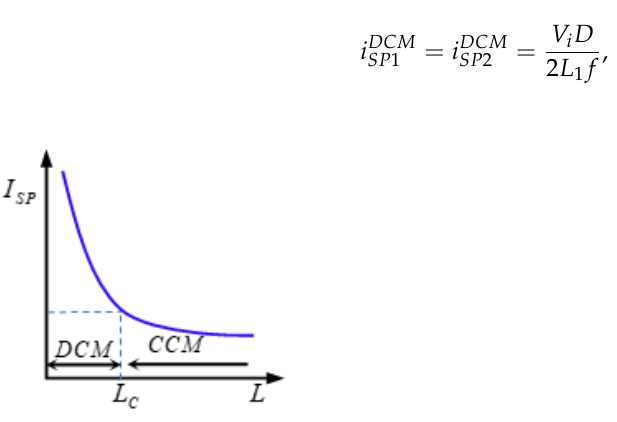
Figure 5. The relation between the value of the inductances and PCFS.